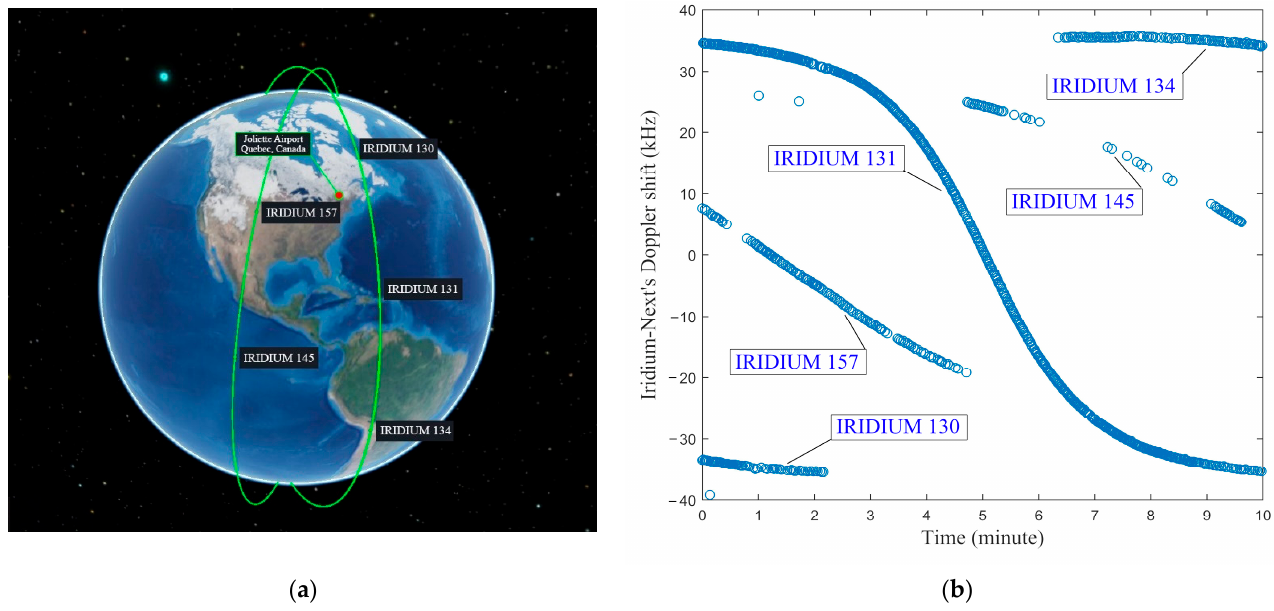
Figure 9. ( a ) 3D Earth representation of the overhead Iridium-Next satellites. ( b ) Doppler shift curve tracked by the re- ceiver.